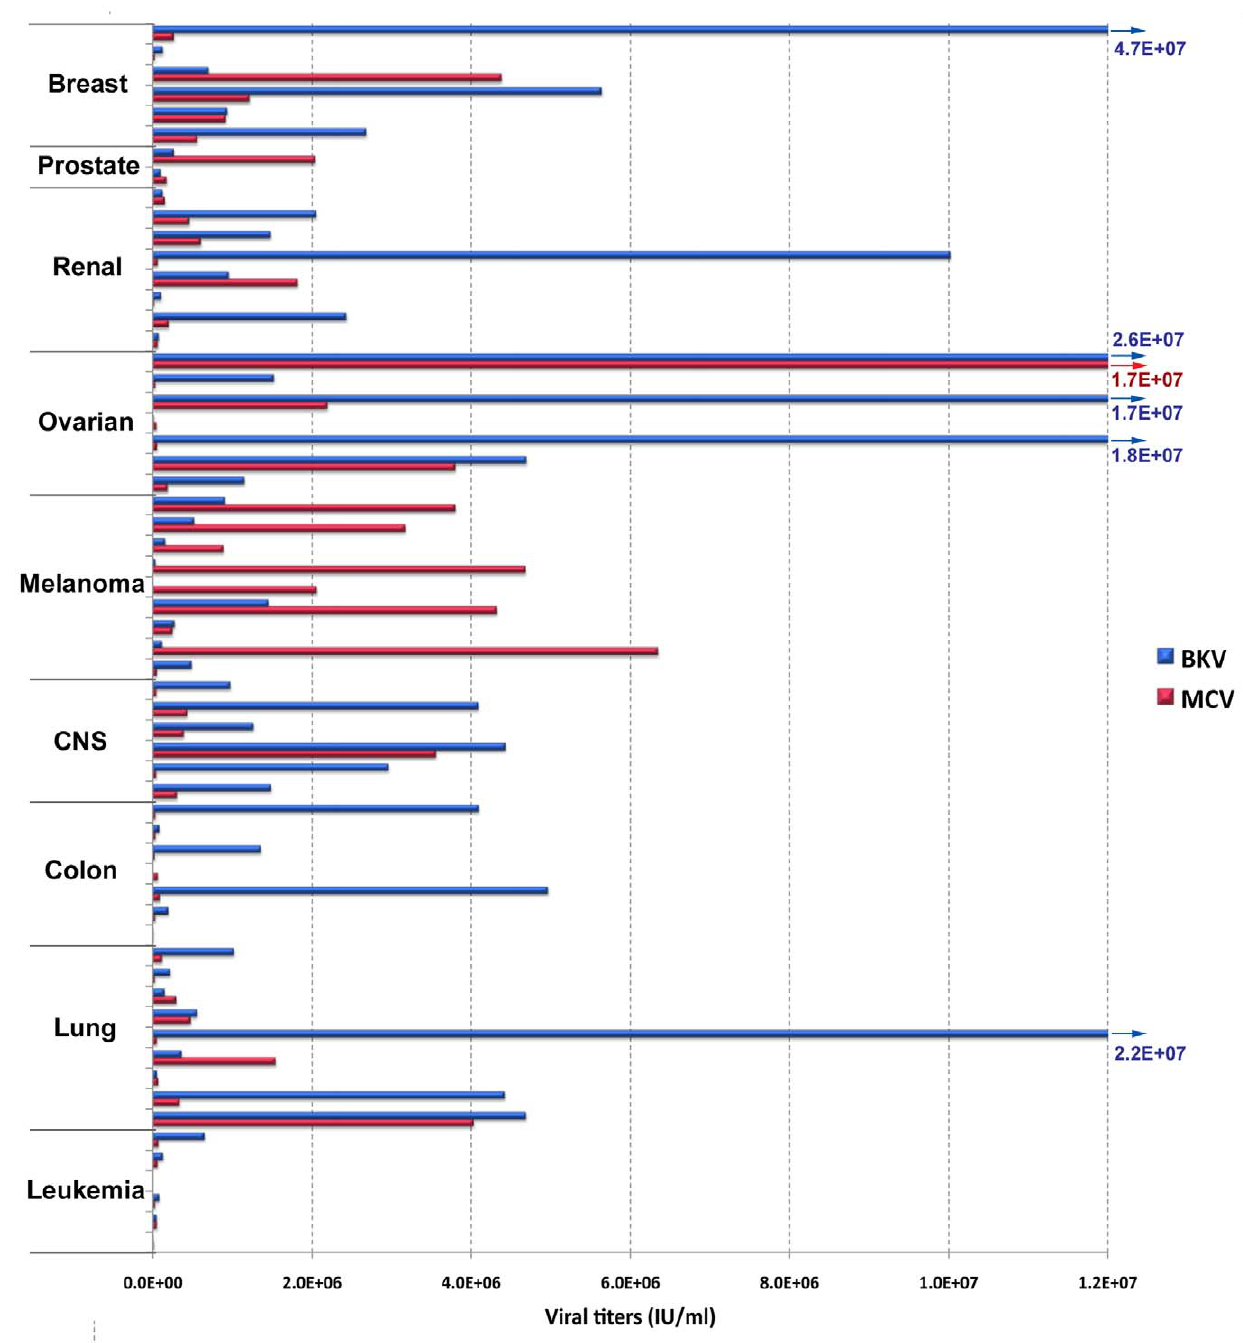
Figure 1. Transducivity of NCI-60 Cell Lines. A graphical representation of the GFP-reporter pseudovirus titers listed in Table 1. doi:10.1371/journal.pone.0042181.g001 Using NCI-60 PatternMiner software, we used the GLuc and GFP data sets to search for positive correlations between cellular gene expression and relative transducibility. Consistent with the hypothesis that enhanced secretion of the GLuc reporter gene by the melanoma lines artificially inflated their apparent transduci- bility, top hits for the GLuc titer analysis included a large number of melanocyte-specific genes involved in secretion and melano-